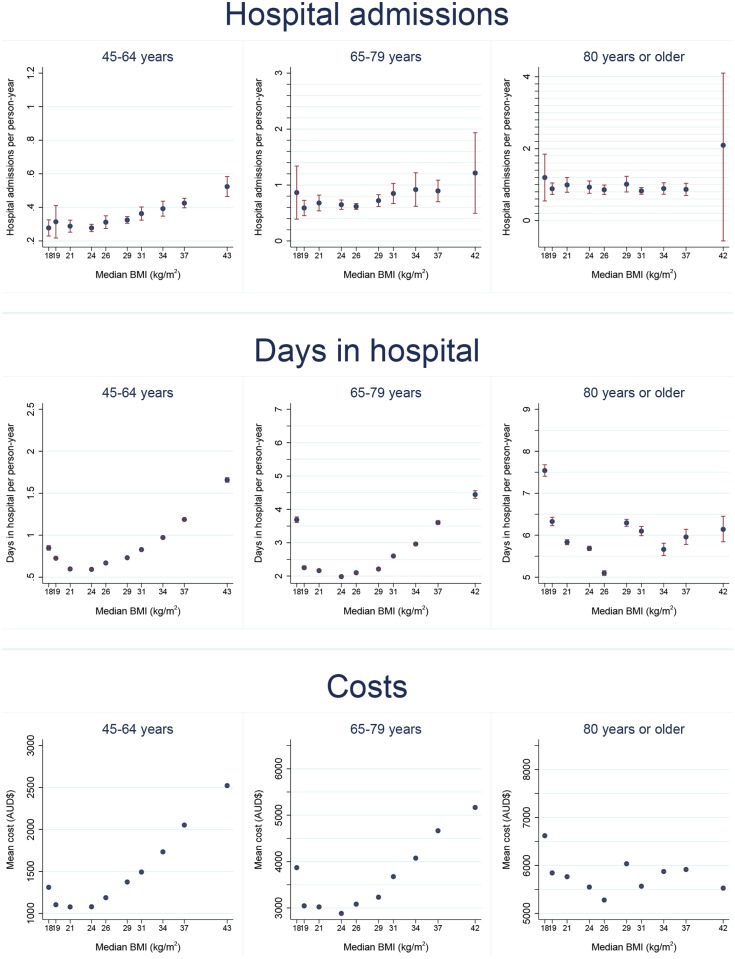
Age-standardised hospital admissions, days in hospital and costs per person-year (with 95% CIs) by body mass index (BMI), females.Notes. 1. Within each age group, rates are age-standardised to the 2006 NSW population (in 5 year age-groups) using the direct method. 2. The upper confidence interval for the 80 years or older age group for hospital admissions has been truncated to 4.1 (actual value is 4.8).